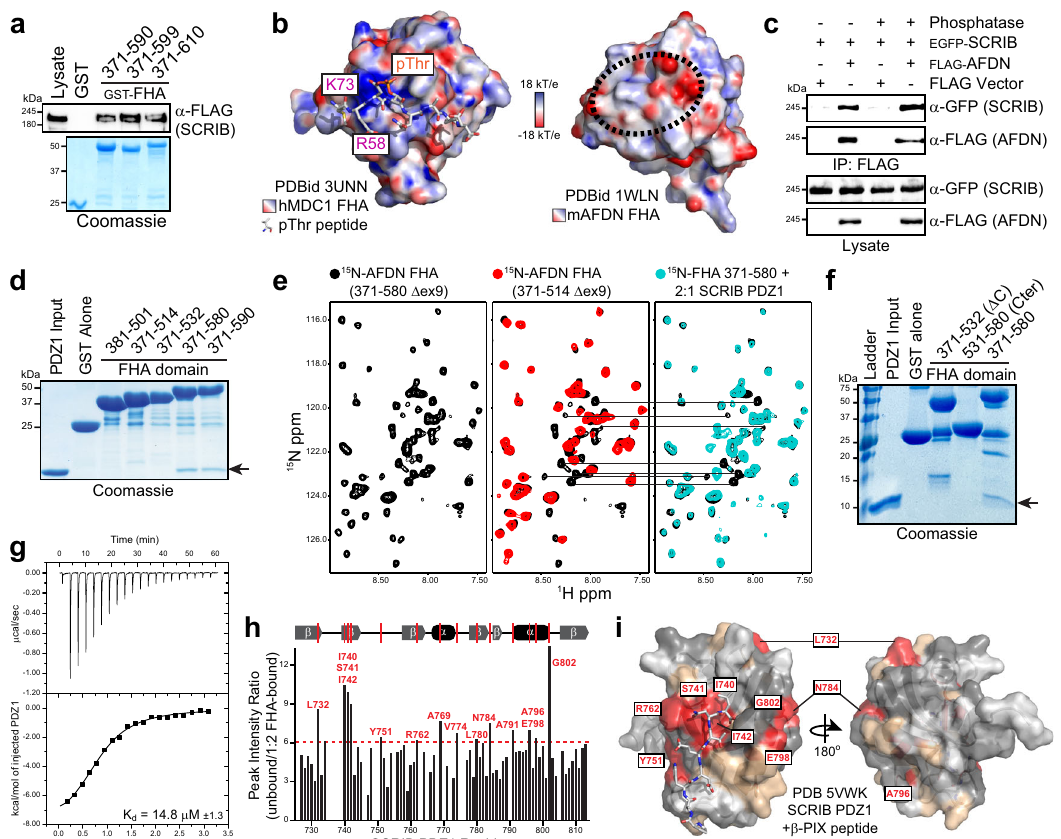
Fig. 3 | AFDN FHA and SCRIB PDZ1interact directly in a phospho-independent manner. a GST-FHA domains with distinct C-termini precipitate full-length SCRIB from lysate. b Lack of positively charged residues on the surface of the AFDN FHA domain.TheelectrostaticsurfaceofMDC1FHAdomain( left )showsthepositionof K73andR58,necessaryforbindingpThr(PDBid3UNN).Electrostaticsurfaceofthe AFDNFHAdomain(PDBid1WLN)revealsno positive charges ( right ; dashed circle). ElectrostaticpotentialwascalculatedusingAPBSandPyMol. c AFDNandSCRIBco- IP following incubation with phosphatase. EGFP-SCRIB and FLAG-AFDN were co- expressed and precipitated with anti-FLAG following treatment with phosphatase. d Puri fi ed SCRIBPDZ1caninteract directlywithGST-tagged AFDNFHA.Fragments end at FHA domain residues 501-590 and could only bind SCRIB PDZ1 if extended past residue 580. GSTalone wasa control. e 1 H/ 15 N-HSQCspectraof the AFDN FHA domain. The extended FHA domain (371-580, black) overlays with the core FHA domain (371-514, red) and exhibits several additional peaks. The same peaks are broadened upon addition of unlabeled SCRIB PDZ1 (right, blue), verifying